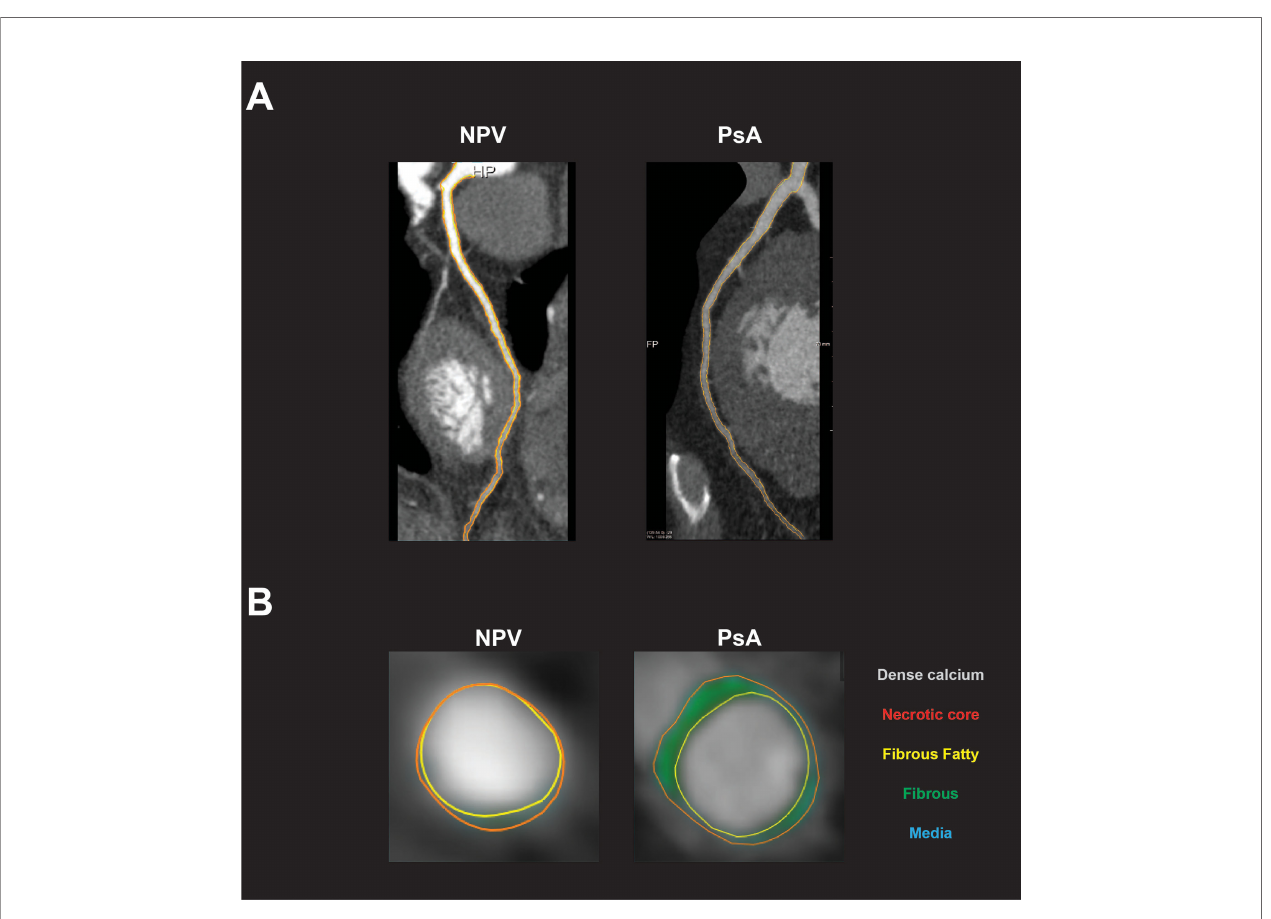
FIGURE 3 | Subclinical coronary artery disease in patients with psoriatic arthritis. (A) Representative coronary artery CT angiogram (CCTA) images show left anterior descending (LAD) artery in non-psoriatic volunteers (NPV) and patients with psoriatic arthritis (PsA). (B) Representative CCTA images show coronary artery plaque in NPV and PsA. Total burden is determined by measuring the total plaque area (orange) around the lumen (yellow). Non-calci fi ed coronary artery burden (NCB) is determined by calculating the difference between total and dense calci fi ed burden. For these subjects, NCB x 100 = 0.602 (NPV) and 2.108